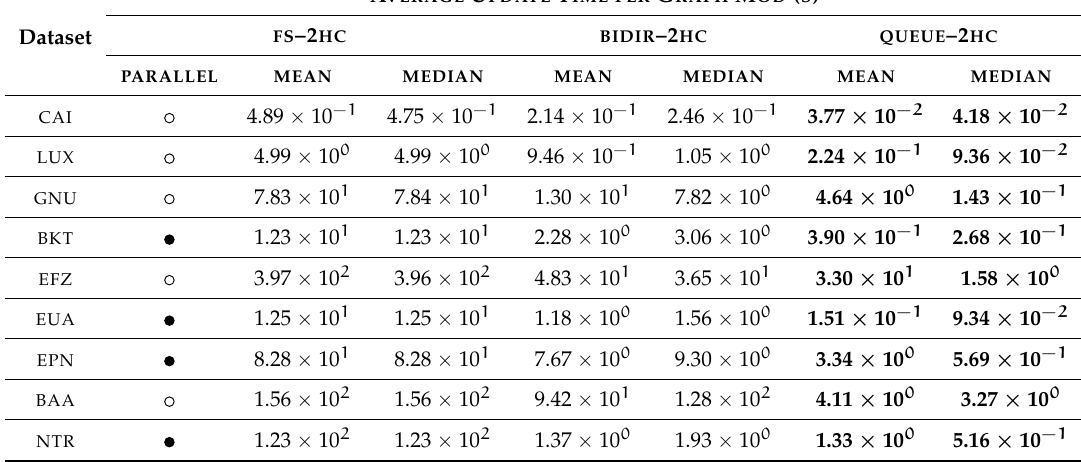
Table 2. Experimental results: average update time of QUEUE –2 HC against that of BIDIR –2 HC and FS –2 HC . For each network, we report both mean and median values. The column named PARALLEL indicates whether FS –2 HC is accelerated by executing part of its code in parallel among the cores (for unweighted instances [8], = true, =